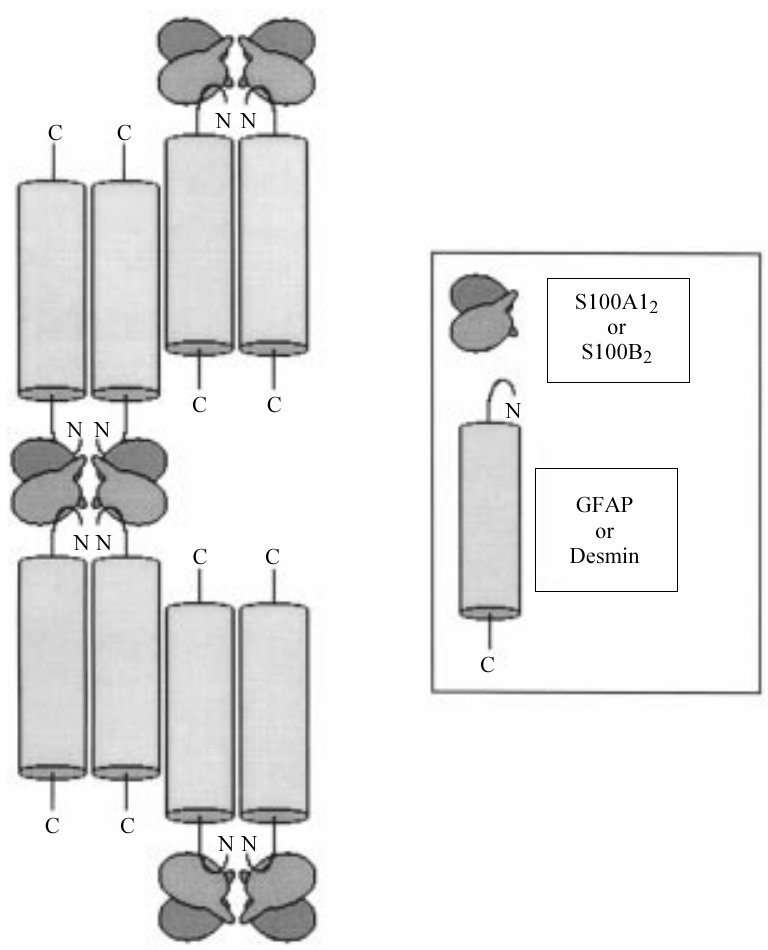
Figure 3 - Schematic representation of the Ca 2+ -dependent interaction between S100A1 2 or S100B 2 dimers and desmin or glial fibrillary acidic protein (GFAP) tetramers. A pair of S100 2 dimers crossbridges two desmin or GFAP dimers by interacting with the desmin or GFAP N-terminal domain. Binding of either S100 protein to the N-terminal domain results in inhibition of desmin or GFAP assembly into type III intermediate filaments. Formation of macrocomplexes composed of four desmin or GFAP subunits plus four copies of S100A1 or S100B monomers was observed by chemical crosslinking (see Refs.